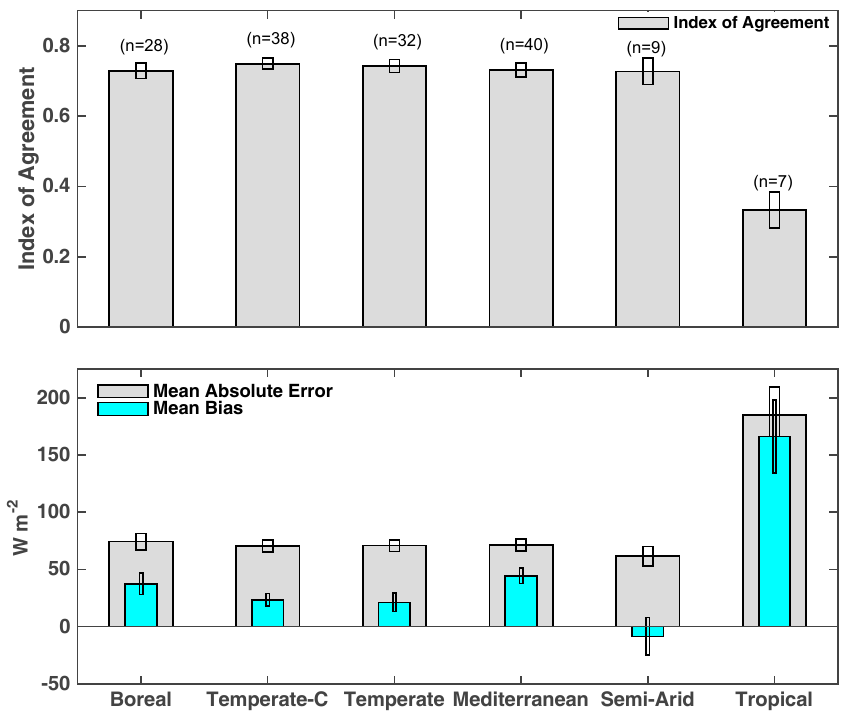
Figure 2. Agreement between instantaneous MODIS and measured net-radiation at satellite overpass time. Temperate-C denotes Temperate-Continental. The numbers atop the bars in the upper panel show the number of sites in each of the six climate types.